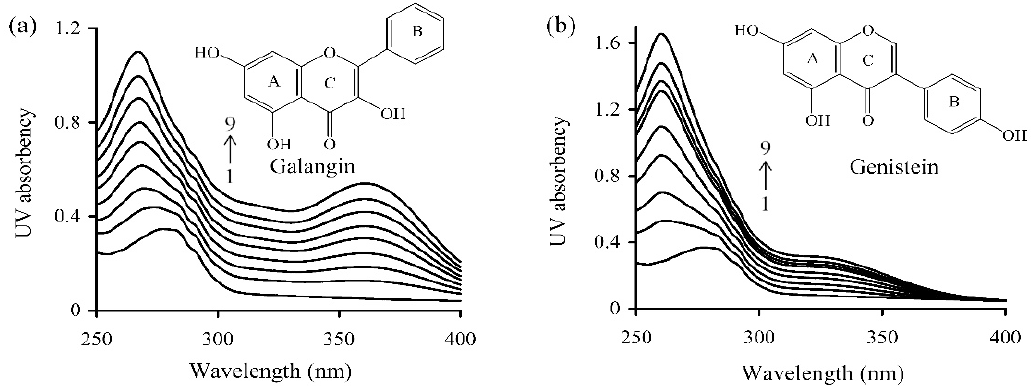
Figure 3. UV absorption spectrum of WPI solution without or with galangin ( a ) or genistein ( b ). WPI was used at 20 μ mol/L, while galangin/genistein was used at 0, 5, 10, 15, 20, 25, 30, 35, and 40 μ mol/L (from 1 to 9).